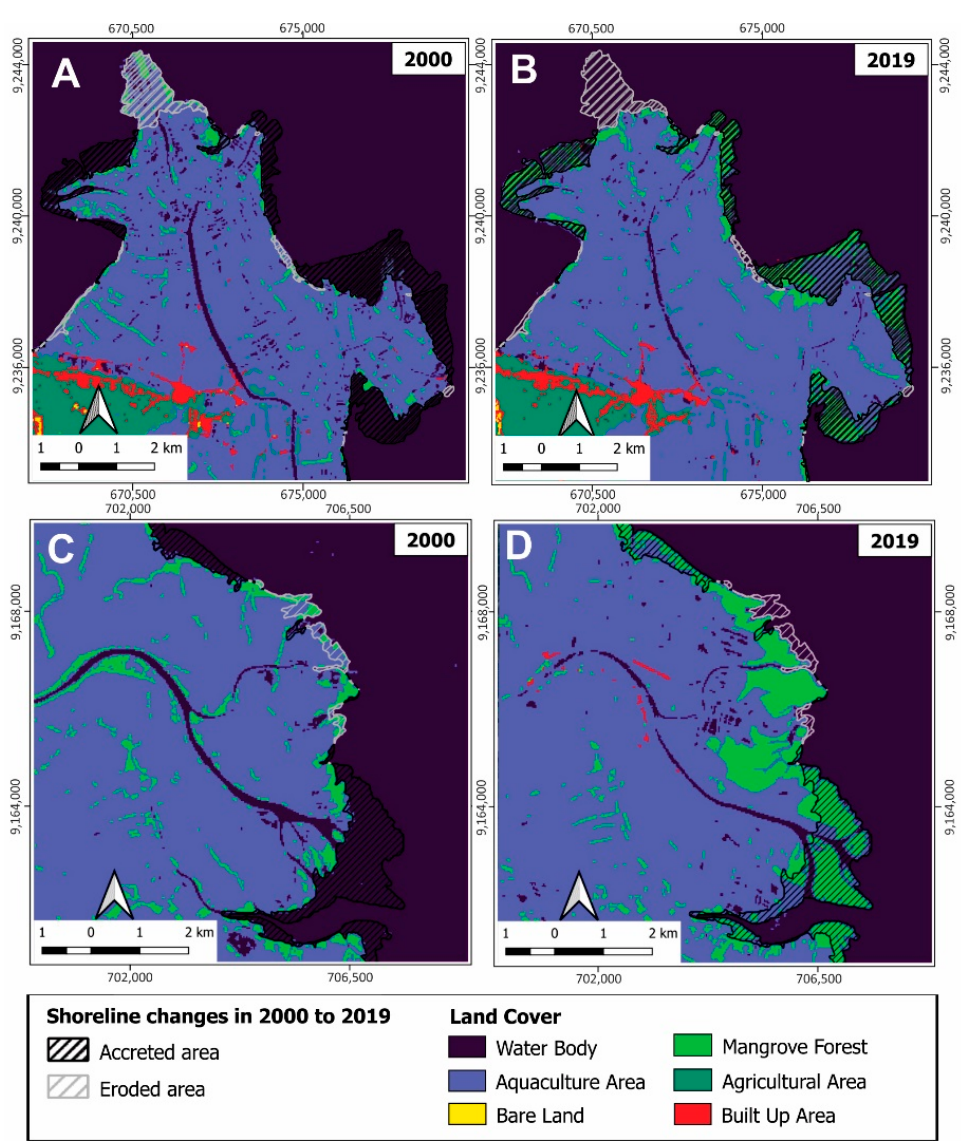
Figure 9. Land-use composition and shoreline changes from 2000 to 2019 in the Bengawan Solo river in ( A ) 2000 and ( B ) 2019 and in the Brantas/Porong river in ( C ) 2000 and ( D ) 2019.